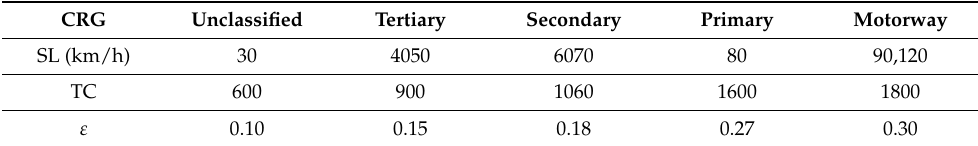
Table 3. Comparison table of urban road network capacity.